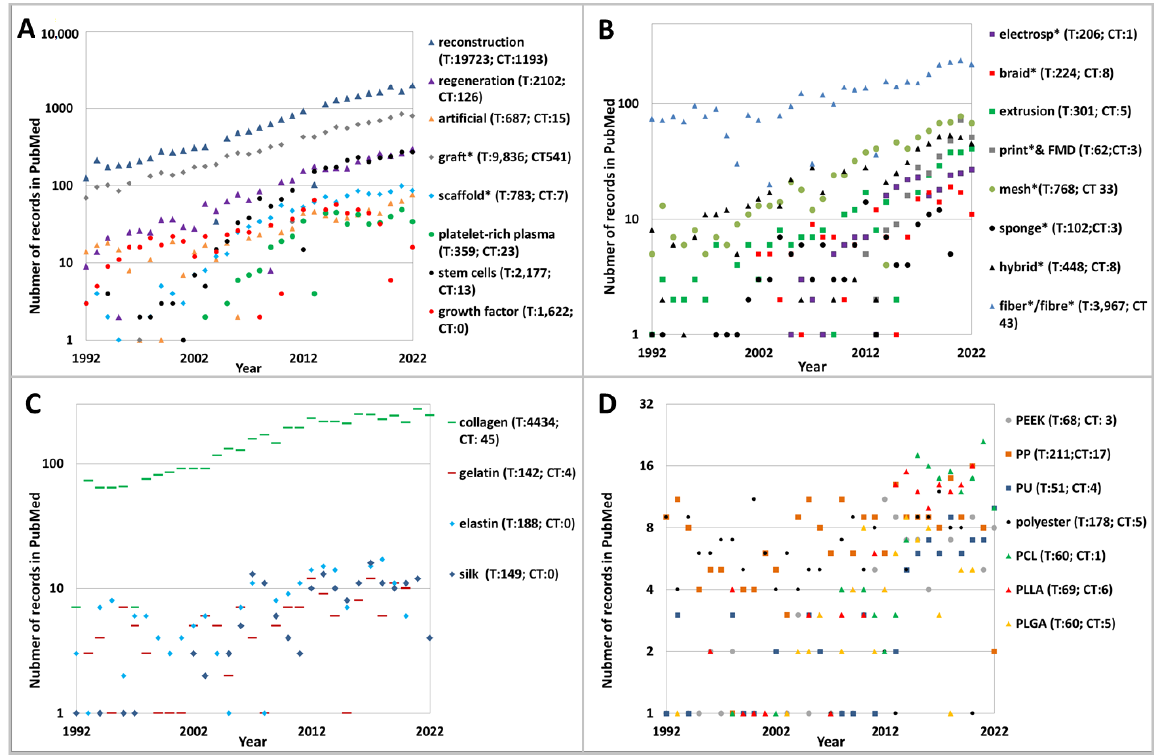
Figure 2. The number of publications in the PubMed database concerned: ( A ) reconstruction, regeneration, artificial, graft, scaffold, stem cells, growth factors platelet-rich plasma; ( B ) electrosp*, extrusion*print*&FDM, fiber*/fibre*, braid*, mesh*, sponge*, hybrid*; ( C ) collagen, gelatin, silk, elastin; ( D ) polyester, PEEK, PET, PP, PU, PLGA, PLCL, PLA PCL.